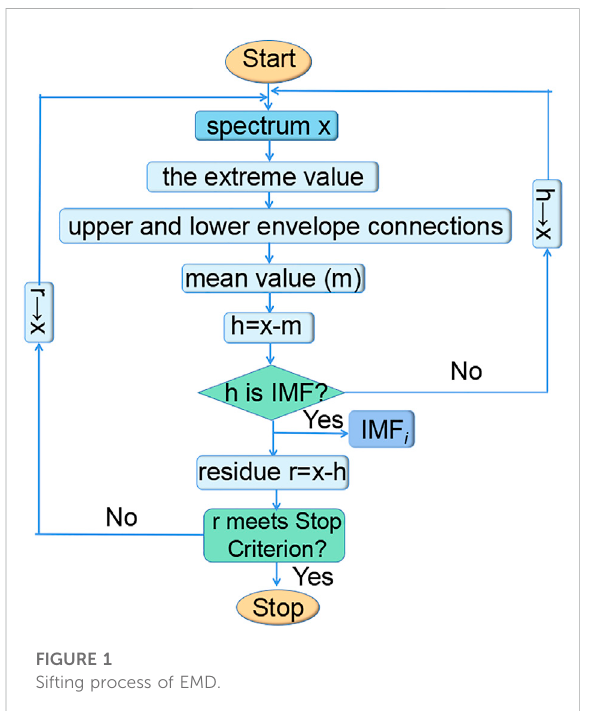
FIGURE 1 Sifting process of EMD.